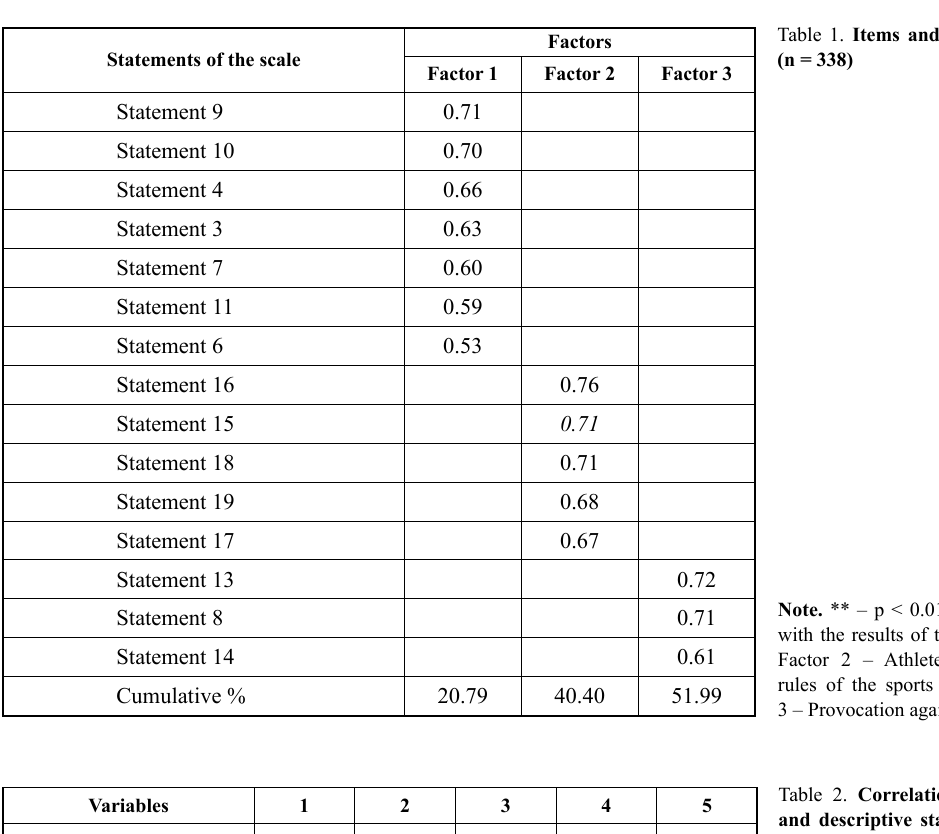
Table 1. Items and factor loading for JDSS (n = 338)